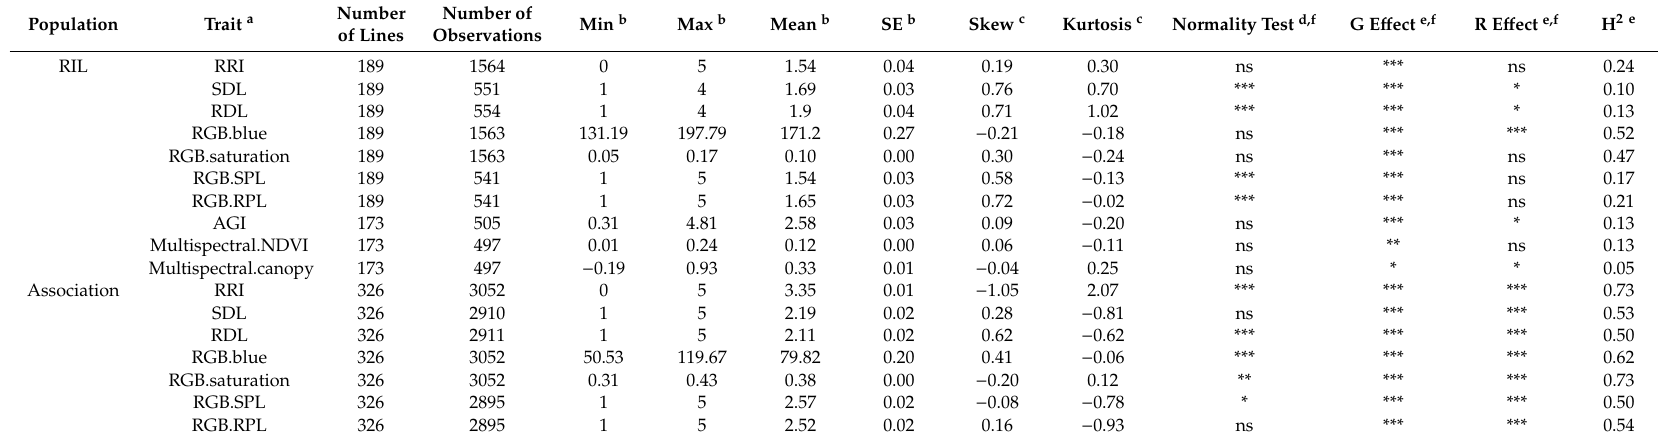
Table 1. Statistical analysis results of all the Aphanomyces root rot (ARR) resistance traits in the recombinant inbred line (RIL) population and the association mapping